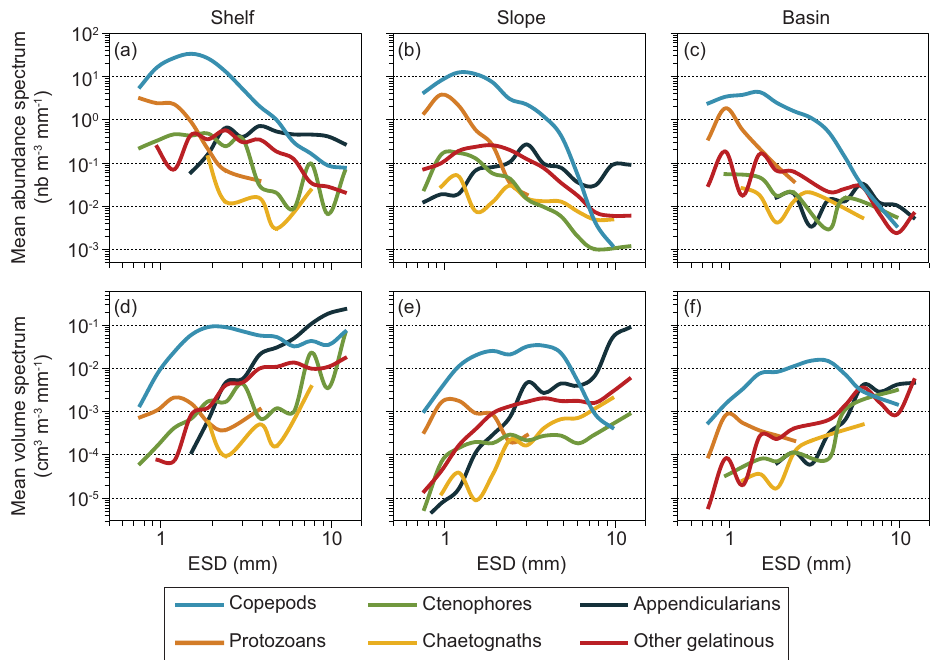
Fig. 6. Mean size spectra of abundance (a–c) and biovolume (d–f) for each zooplankton group as identified and measured with the Underwater Vision Profiler deployed across the shelf-slope-basin interface in the southeast Beaufort Sea in July–August 2009. ESD: equivalent spherical